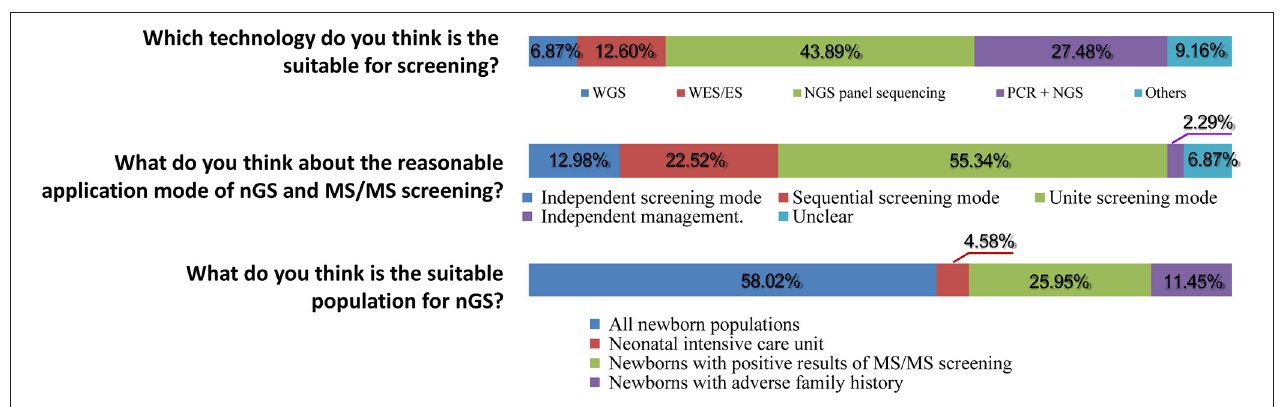
FIGURE 3 | Knowledge of nGS (single